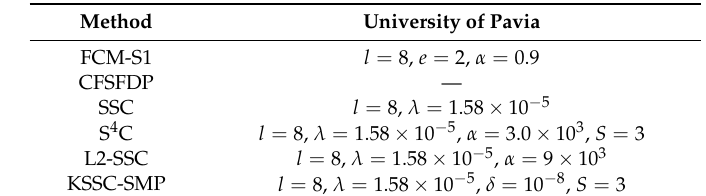
Figure 4. The cluster maps of the different methods for the University of Pavia image: ( a ) false-color image (R: 102, G: 56, B: 31); ( b ) ground truth; ( c ) FCM-S1; ( d ) CFSFDP; ( e ) SSC; ( f ) S 4 C; ( g ) L2-SSC; and ( h ) KSSC-SMP. Table 6. Quantitative evaluation of the different clustering algorithms for the University of Pavia image. Table 5. Parameters of each clustering method for the University of Pavia image: fuzzy c -means The best result in each row is shown in bold, with the second-best result underlined. with spatial information (FCM-S1), clustering by fast search and find of density peaks (CFSFDP), sparse subspace clustering (SSC), spectral-spatial sparse subspace clustering (S 4 C), (cid:96) 2 -norm regularized sparse subspace clustering (L2-SSC), and kernel sparse subspace clustering with a spatial max pooling operation